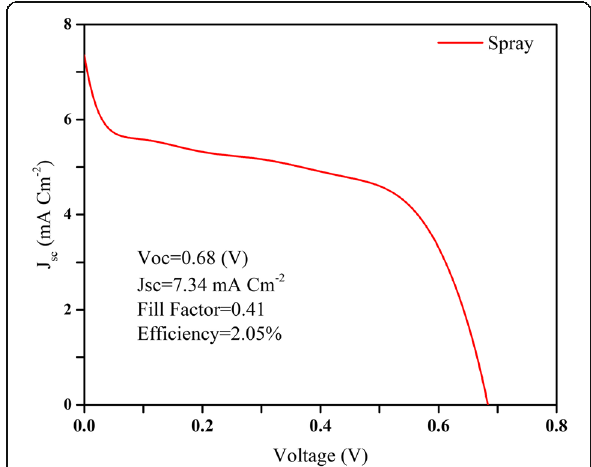
Fig. 8 JV curve and photovoltaic parameters of a solar